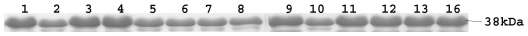
Separation of purified recombinant HA1 proteins of H1–H13 and H16 [14] subtypes (38 kDa) in SDS-PAGE.